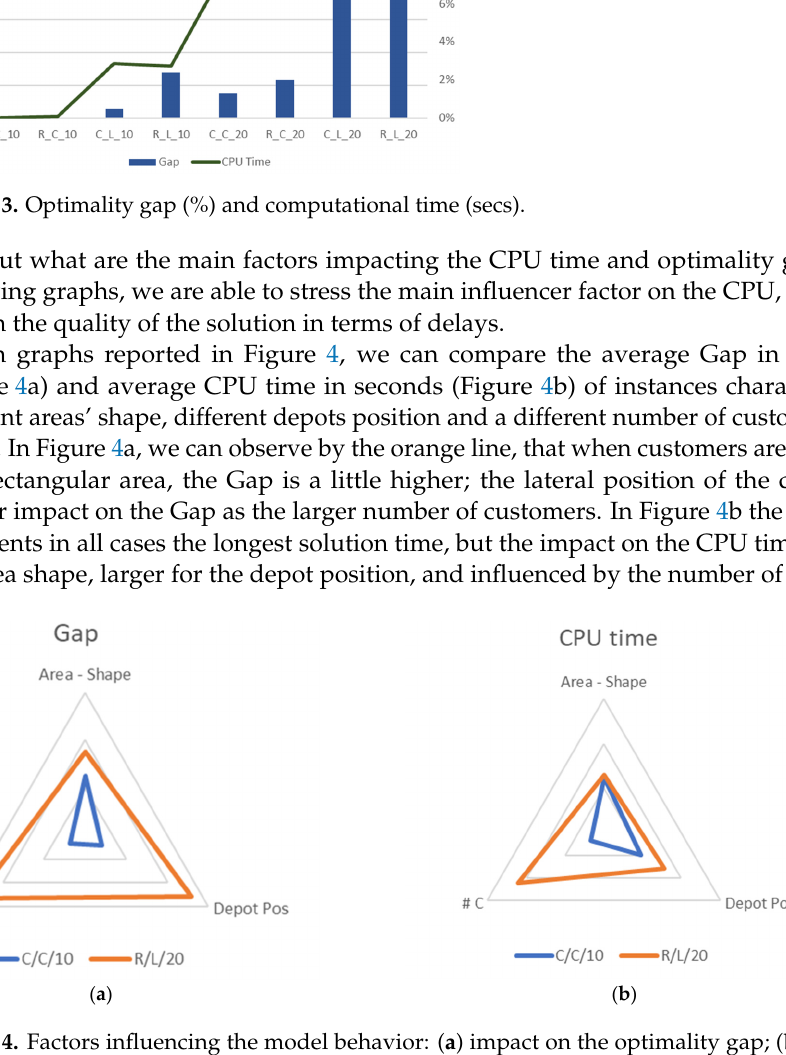
Figure 5. Postponed deliveries. Finally, we show in the graph of Figure 6 the impact of time window durations on the complexity of the model. We can easily note that larger time windows have an impact on both CPU time and the optimality gap. In particular, instances with a 1-h time window are solved up to optimality in an average CPU time of 36.75 s, while 727.50 and 1140.38 s are required to solve instances with 2- and 3-h time windows. The average gaps have the same trend and pass from 0 to 0.02 and 0.07.